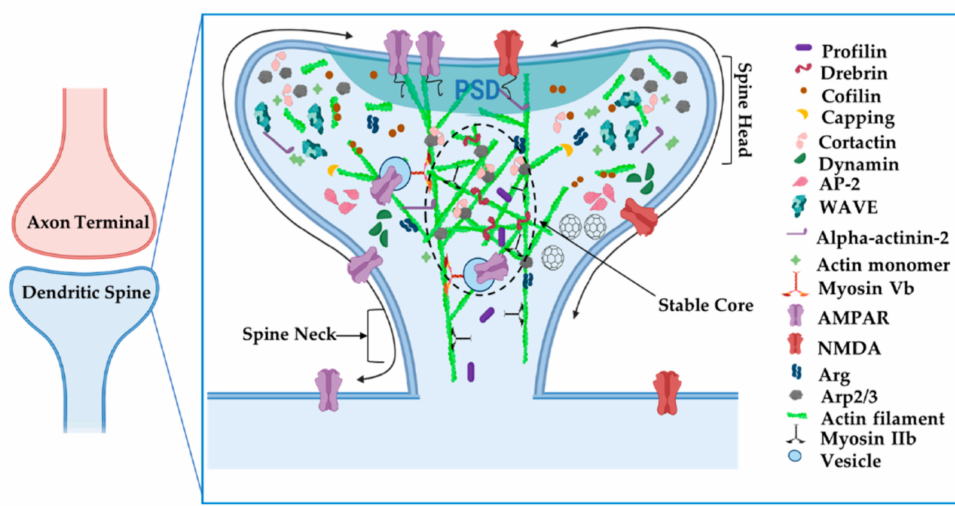
Figure 6. Organization of actin cytoskeleton at the postsynaptic dendritic spine. Actin filaments have specialized compartments, such as the stable actin core, that affect synapse structure and function. Actin-associated proteins localize to specific areas to carry out their functions. Adapted from “Axonal-dendritic synaptic cleft and Protruding membrane”, by https://BioRender.com (accessed on 26 January 2022) (2020). Created and retrieved from https://app.biorender.com/biorender-templates (accessed on 26 January